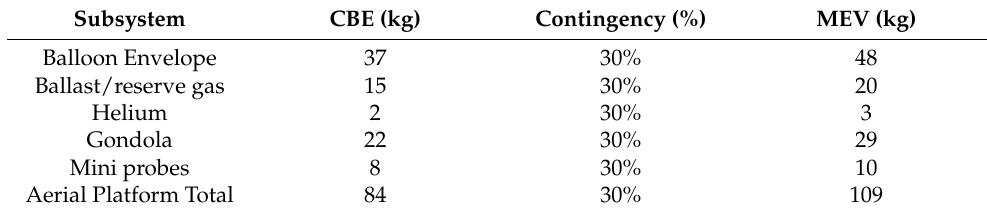
Table 6. Mass breakdown of the aerial platform. Subsystem CBE (kg) Contingency (%) MEV